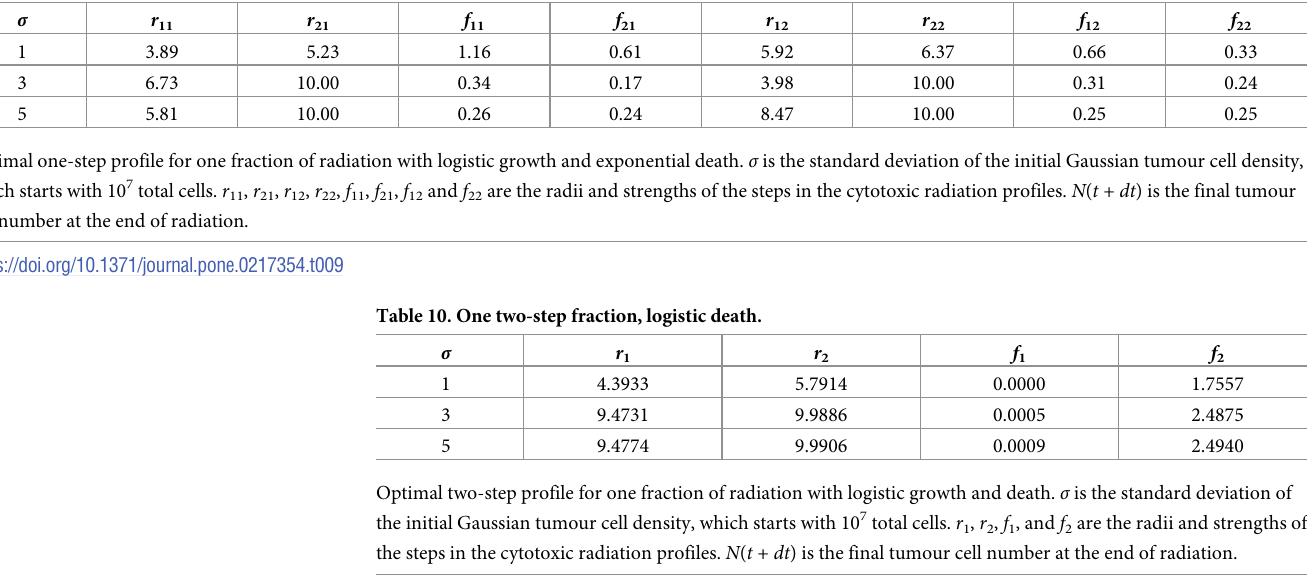
The results of the Monte Carlo optimization are summarized in Table 10. Table 9. Two two-step fractions, each separately constrained for logistic growth.